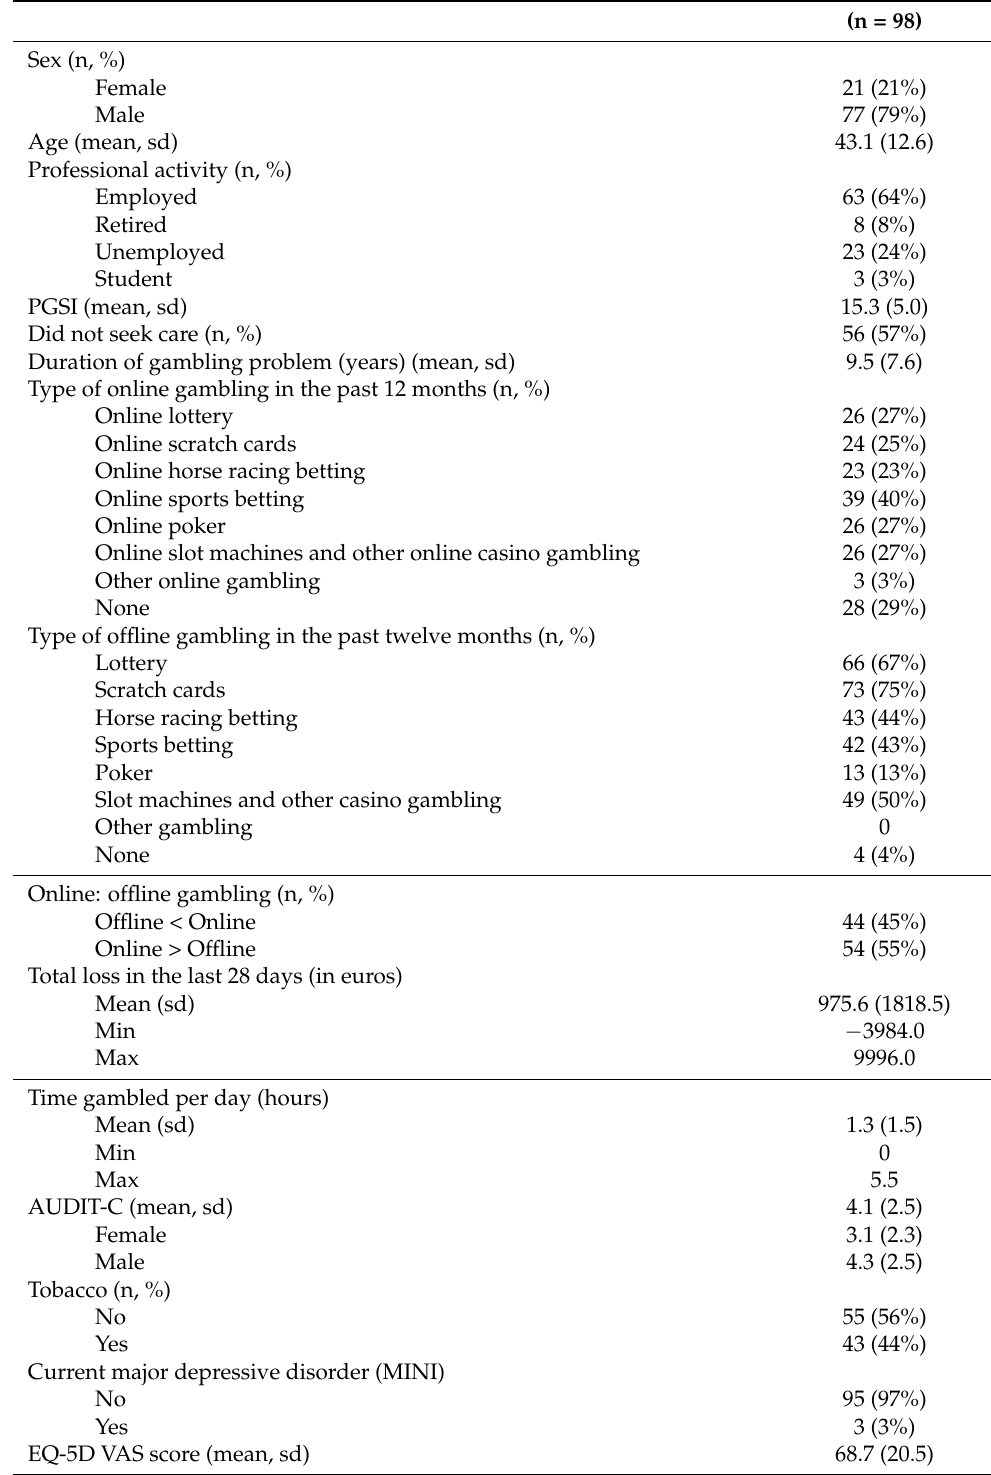
Table 2. Description of the study